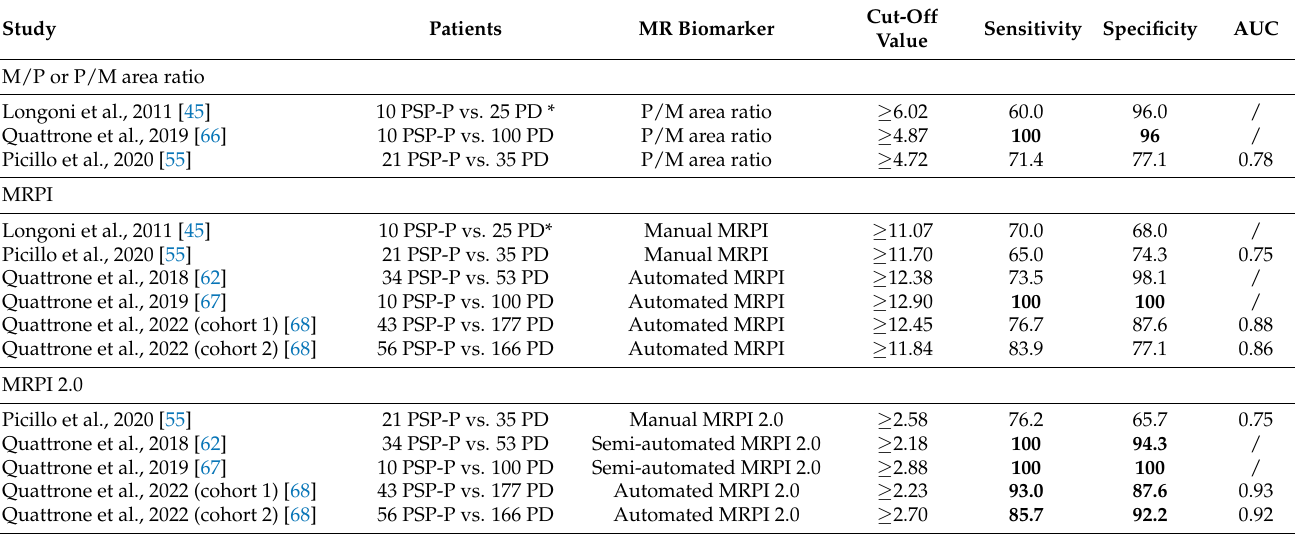
Note to Table 3: Studies showing both sensitivity and specificity above 80% are highlighted in bold. Studies aiming to differentiate PSP from MSA or non-PSP patients (including combinations of PD, MSA, and controls) and studies with sample sizes smaller than 10 patients were not included in the table. Abbreviations: PSP-P— progressive supranuclear palsy-parkinsonism; PD—Parkinson’s disease; AUC—area under the receiver operating